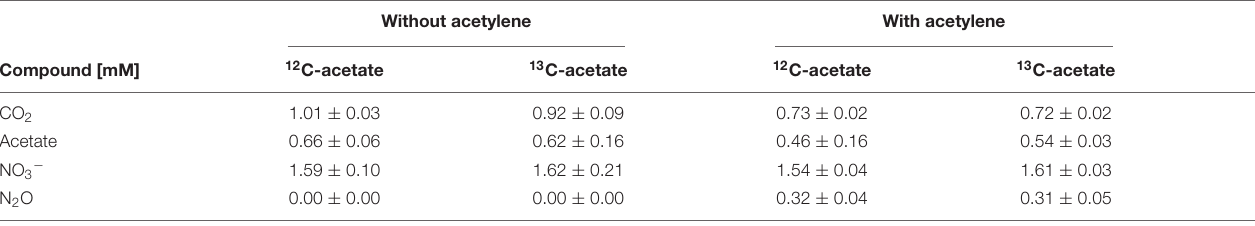
TABLE 1 | Cumulated supplementation of acetate and nitrate, and cumulated production of carbon dioxide and nitrous oxide during incubations in treatments with and without acetylene. Without acetylene With acetylene